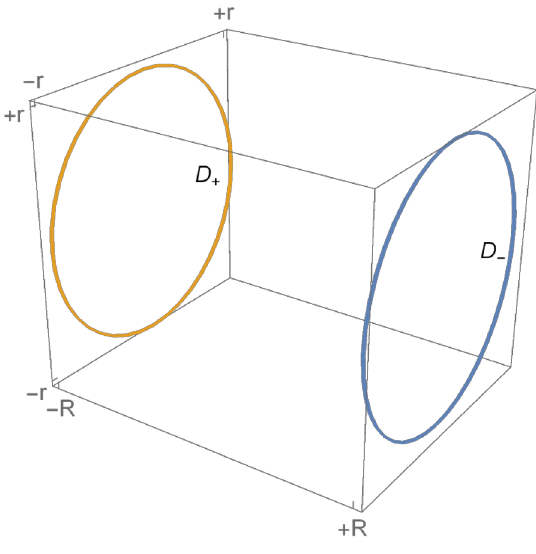
Figure 3 . Two circular defects that are separated by a distance of 2 R